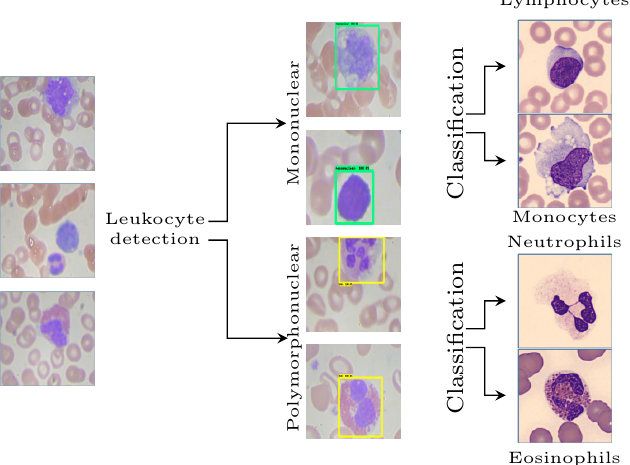
Figure 1. Scheme of identification and classification of white blood cells by the proposed method.